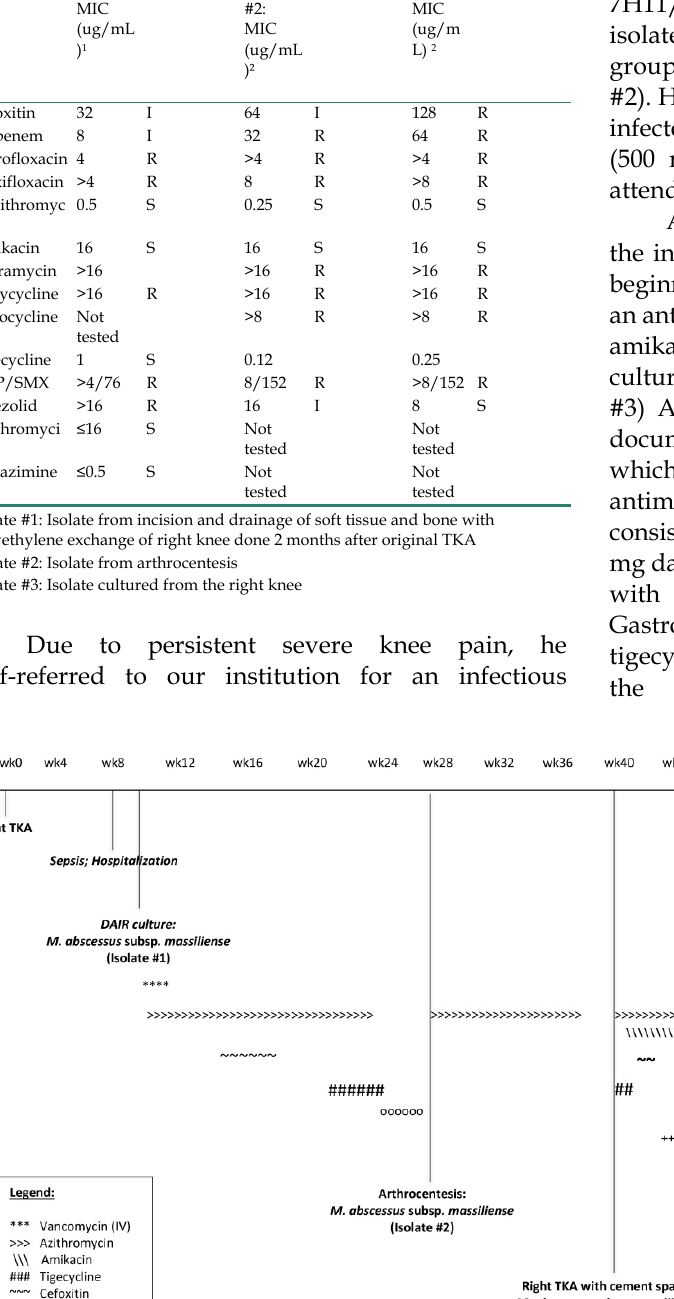
Table 1 : Mycobacterium abscessus subsp. massiliense susceptibility reports Antibiotic